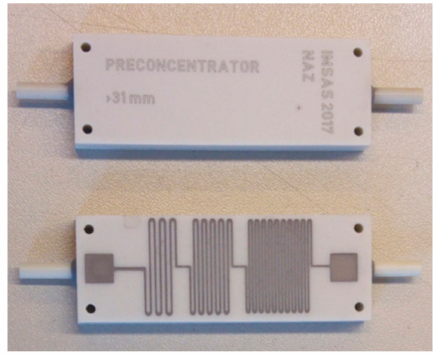
Figure 3. Frontside and backside of the ceramic preconcentrator.